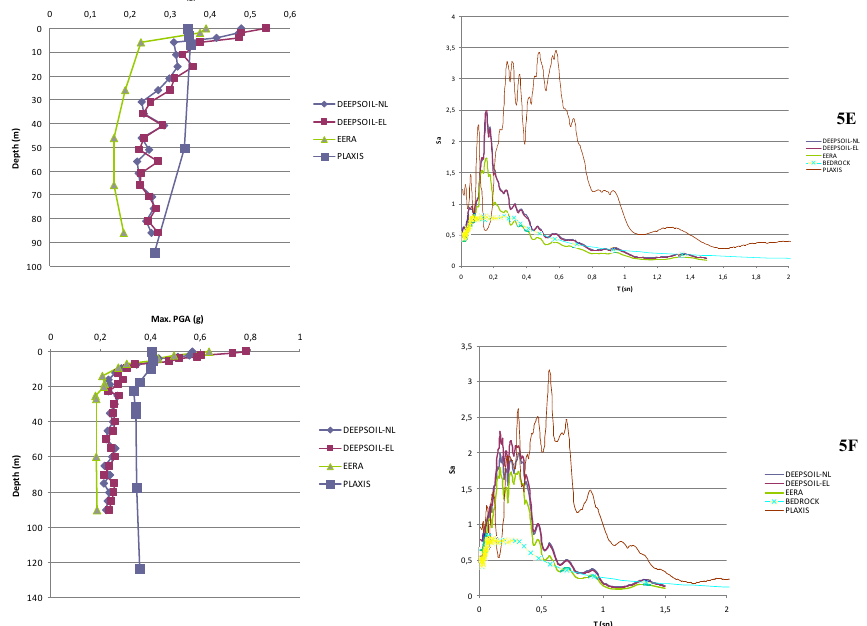
Figure 19. 5-5 0 section; maximum acceleration depth and spectral acceleration period graph for the selected points. Figure 20: For the 5-5’ Section, a simplified model in which the surface and material borders are assumed to be fla